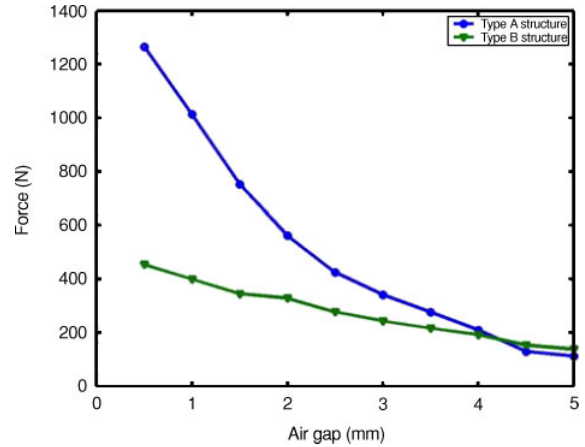
Figure 12 Comparison of the two types of